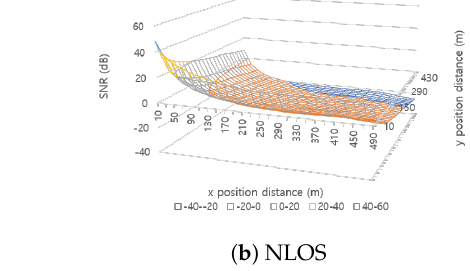
Figure 13. SNR vs